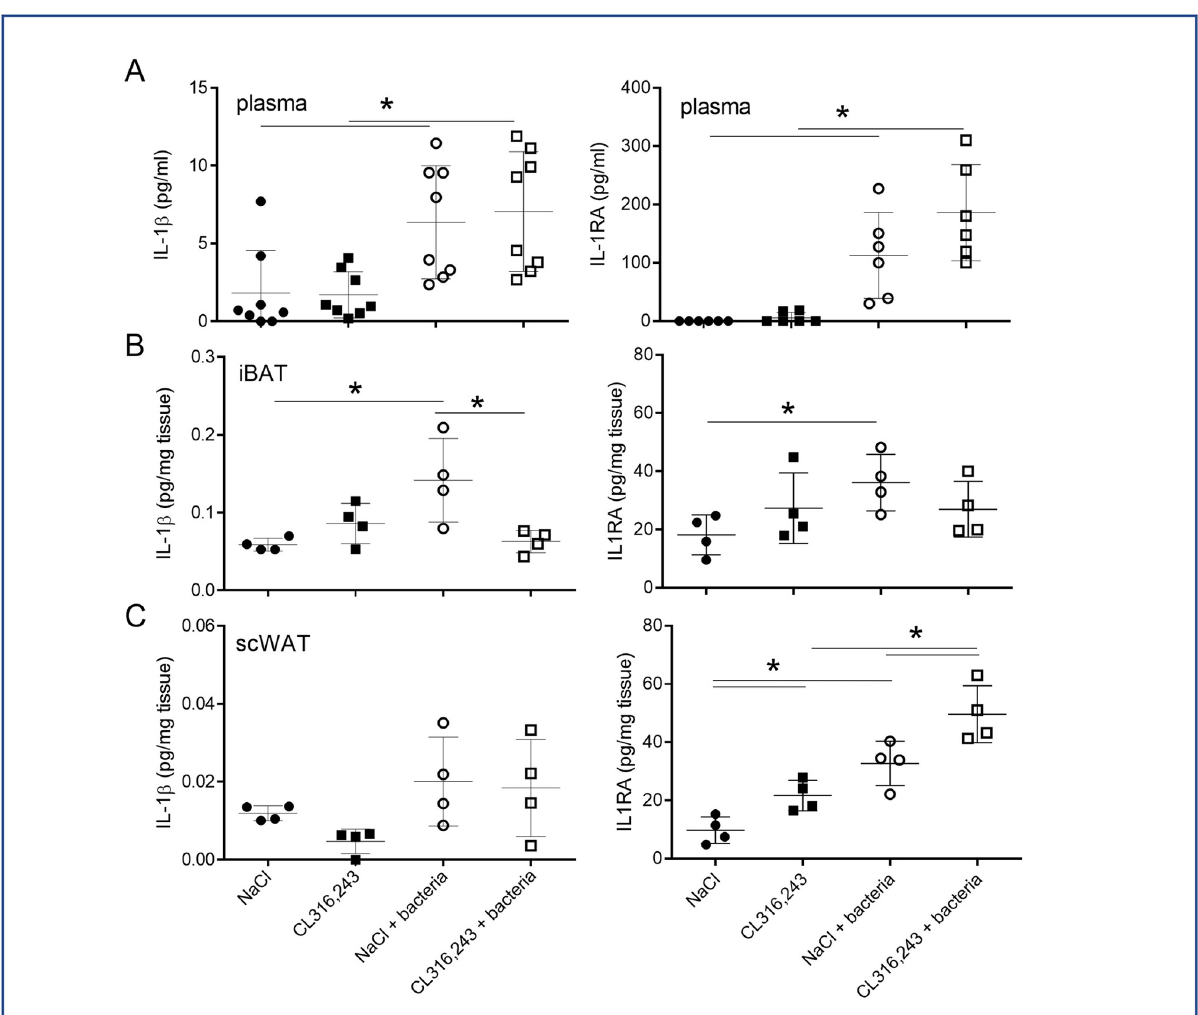
Fig 8. IL-1 pathway response to bacterial infection. IL-1 β (A) and IL-1RA (B) protein levels were assessed in plasma (upper panel) and in the media of iBAT (middle panel) and scWAT (lower panel) explants from mice that were treated for 1 week with CL316,243 daily (1 mg/kg/day) or vehicle only (NaCl), and with or without E . coli infection for 48 hours. The results are displayed as independent values (dots) and the mean ± SD. n = 8 (plasma) or 4 (explant). � p <